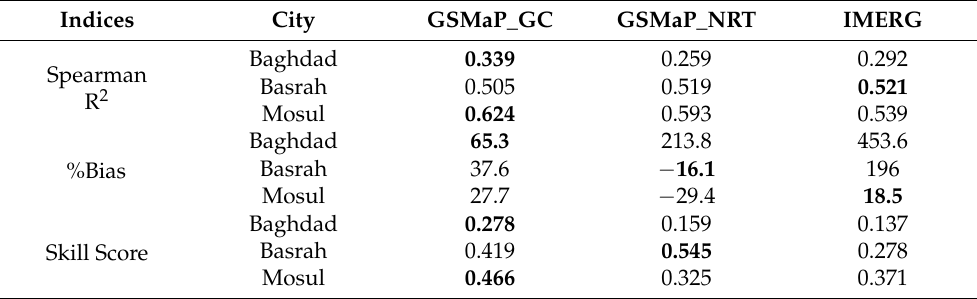
Table 5. Effectiveness of various satellite rainfall data in reproducing daily in situ rainfall in three cities in